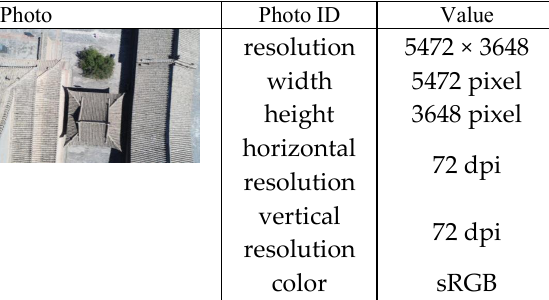
Table 2 . Parameters of the camera carried by the UAV.